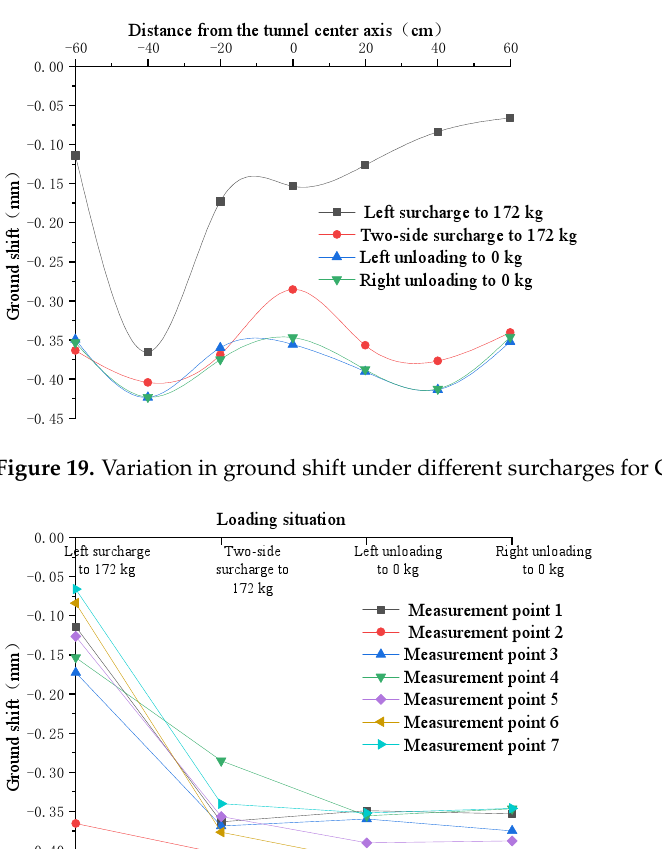
The variation in ground shift under different surcharges for Case 4 is shown in Figure 19, and the variation in the ground shift of each measurement point under dif- ferent surcharges for Case 4 is shown in Figure 20, where the positive values of ground shift represent augmentation and the negative values represent settlement.